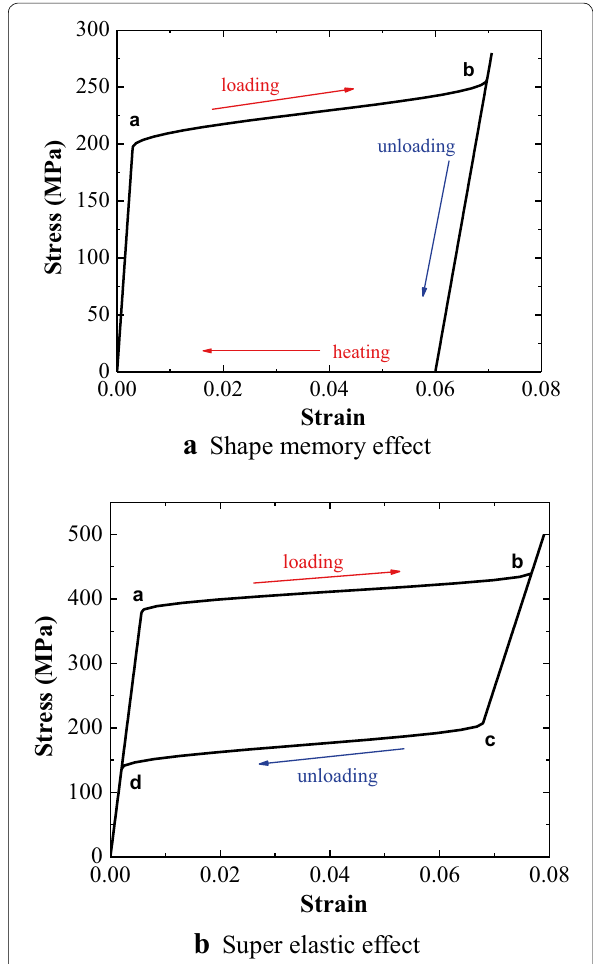
Figure 1 Schematic diagram of shape memory effect and super-elasticity of